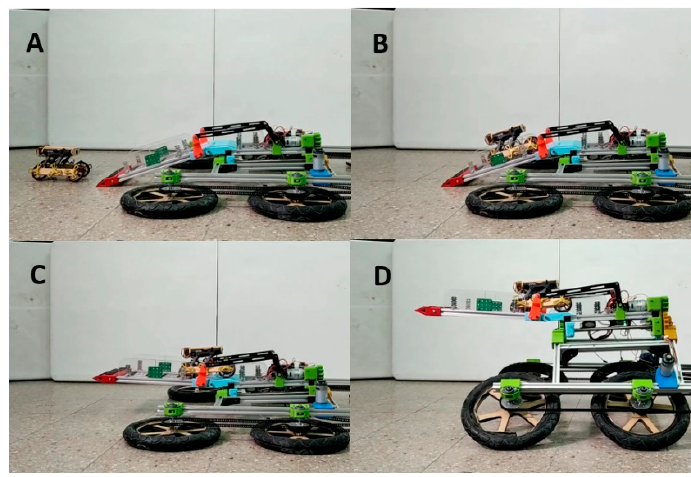
Figure 17. The BSTAR automatically recovering RSTAR (see video in Supplementary Materials). Starting in ( A ), the RSTAR climbs on the ramp ( B ) while the BSTAR lifts its tail ( C ) and body ( D ).